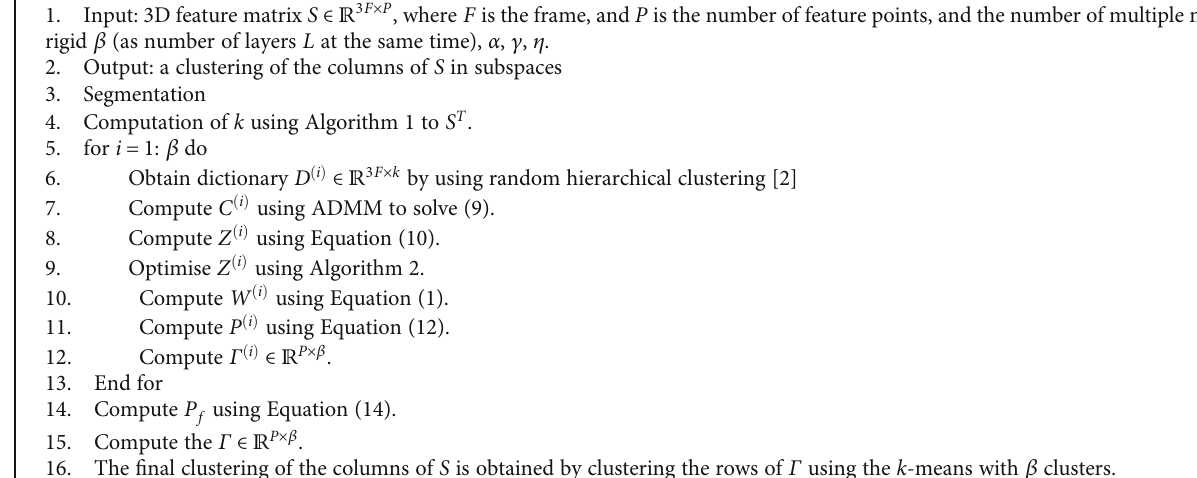
Algorithm 3: Multibody NRSFM